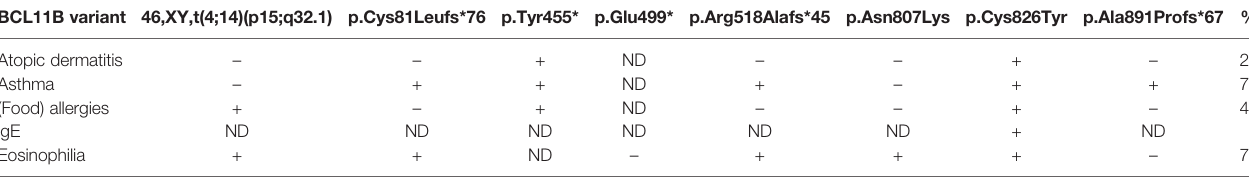
TABLE 3 | Atopy associated with germline BCL11B